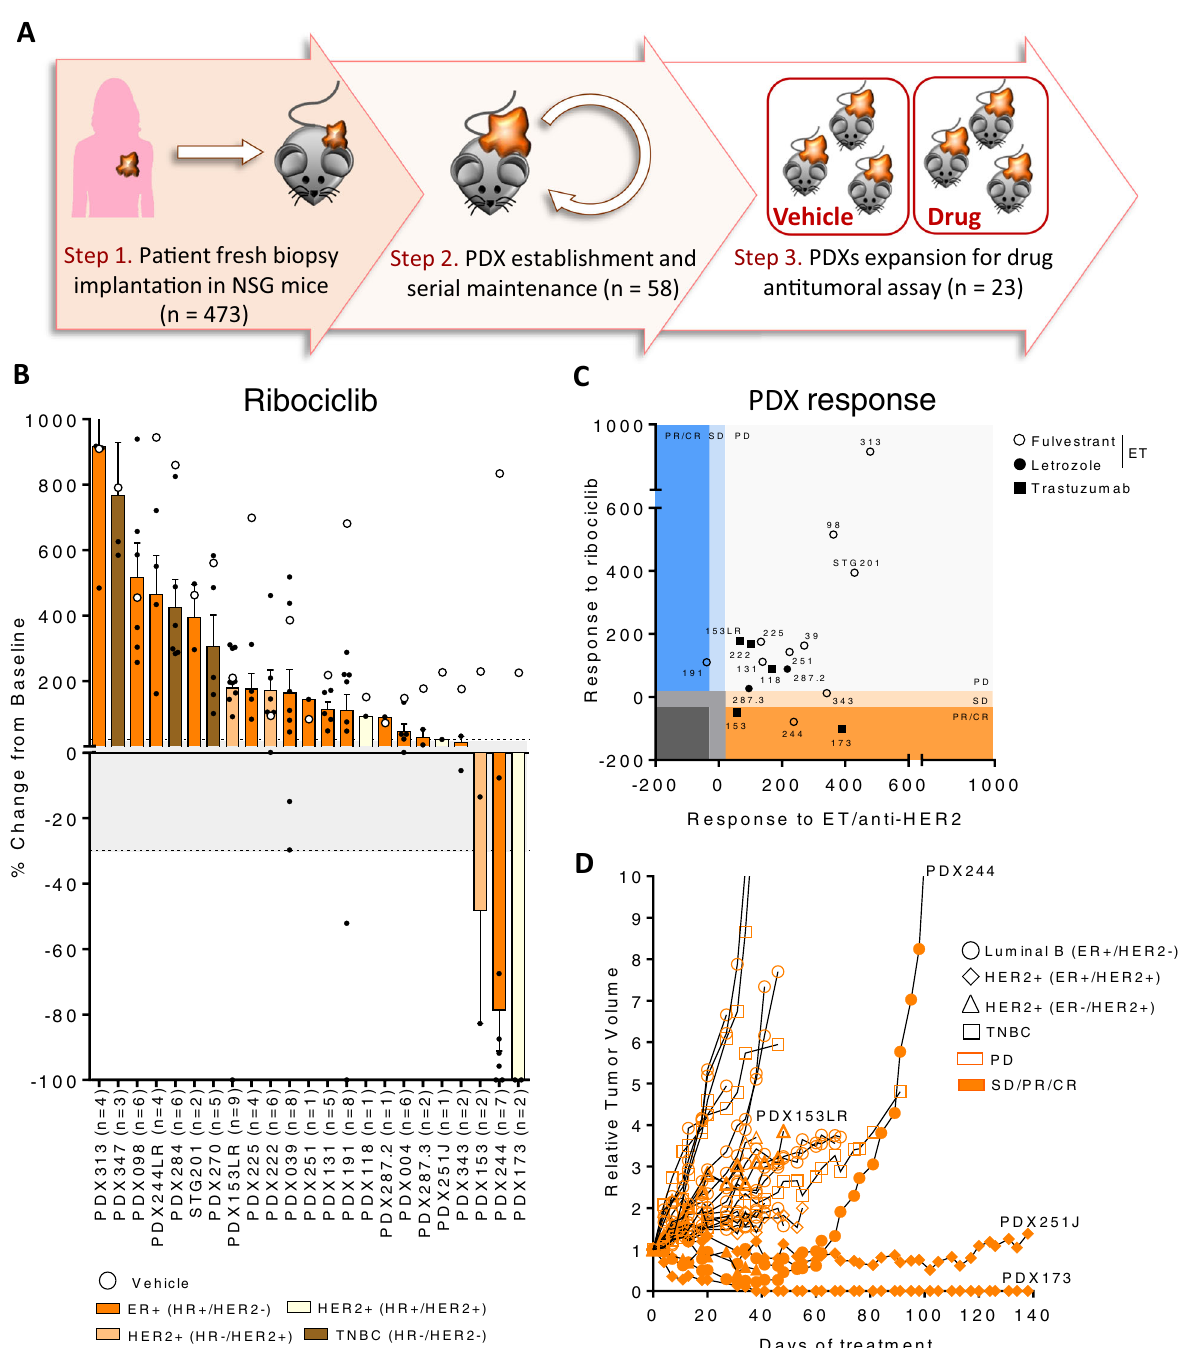
other targeted agents (x-axis; endocrine therapy (ET) or trastuzumab) in PDXs represented as the percentage of tumor volume change compared to the initial tumor volume. Symbols represent the different targeted therapies. D Spaghetti plot showing the relative tumor volume change along time in 23 BC PDX treated with ribociclib 75mg/kg. Ribociclib-sensitive models are represented with fi lled symbols and ribociclib-resistant with open symbols. Symbols represent the PDX ’ s molecularsubtype.DashedlinesindicatetherangeofPD(>1.2),SD(1.2to – 0.7)and PR/CR(< − 0.7).AcquisitionofribociclibresistanceinPDX244(PDX244LR)isshown. Source data are provided as a Source Data fi